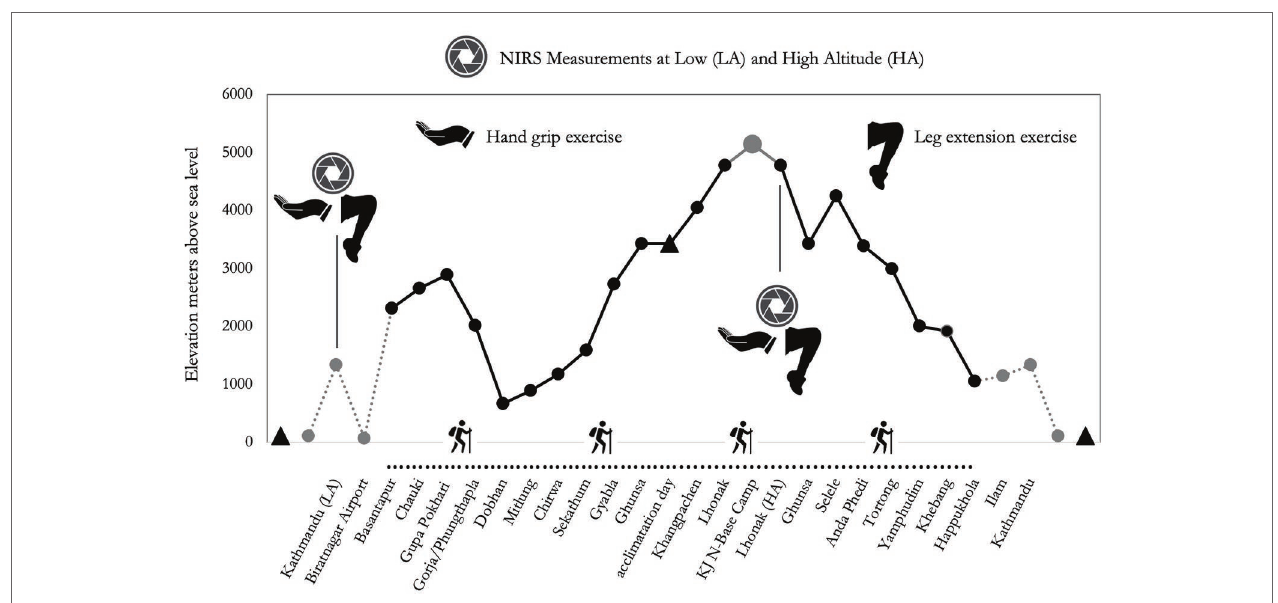
FIGURE 1 | Altimetric plan of the “Kanchenjunga Exploration & Physiology” project. Measurements refer to near-infrared spectroscopy (NIRS) assessment, both on forearm (handgrip task) and anterior thigh (leg extension